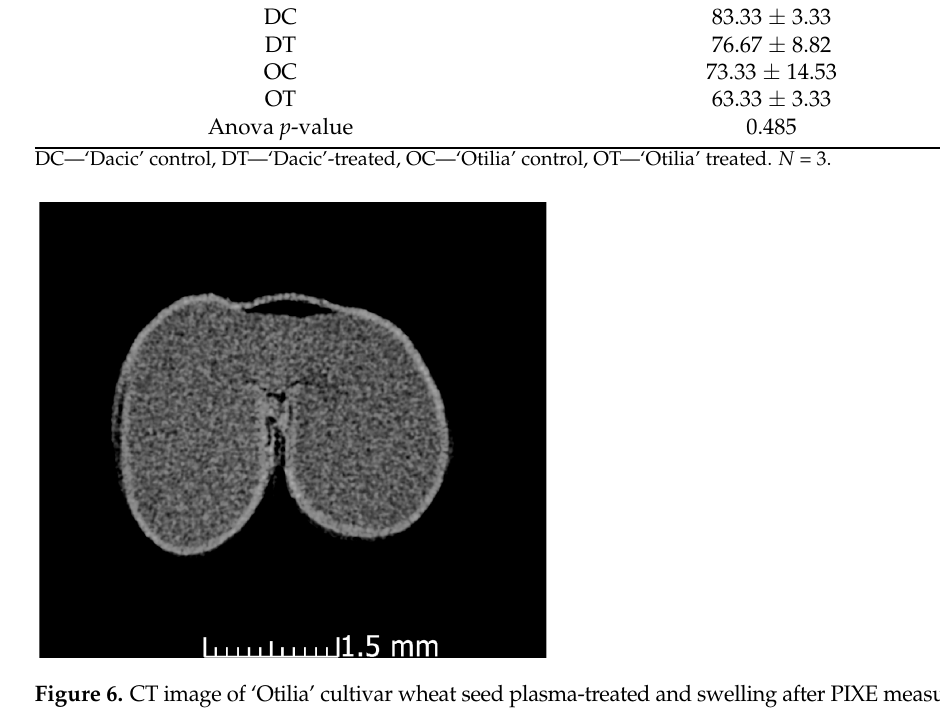
Figure 6. CT image of ‘Otilia’ cultivar wheat seed plasma-treated and swelling after PIXE meas- urement. Table 3. Bran thickness for control and plasma treated-wheat seeds.